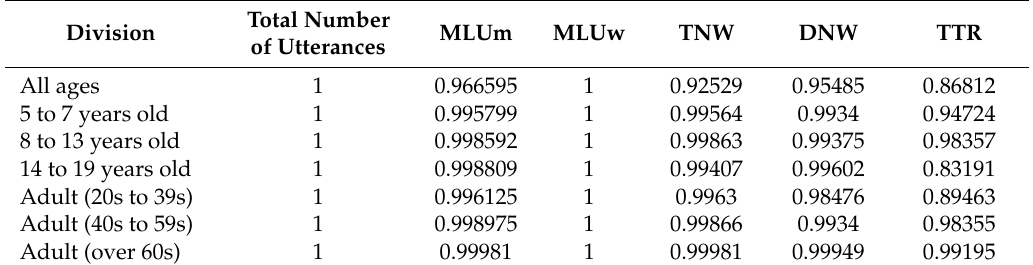
Table 4. Comparison between machine and human